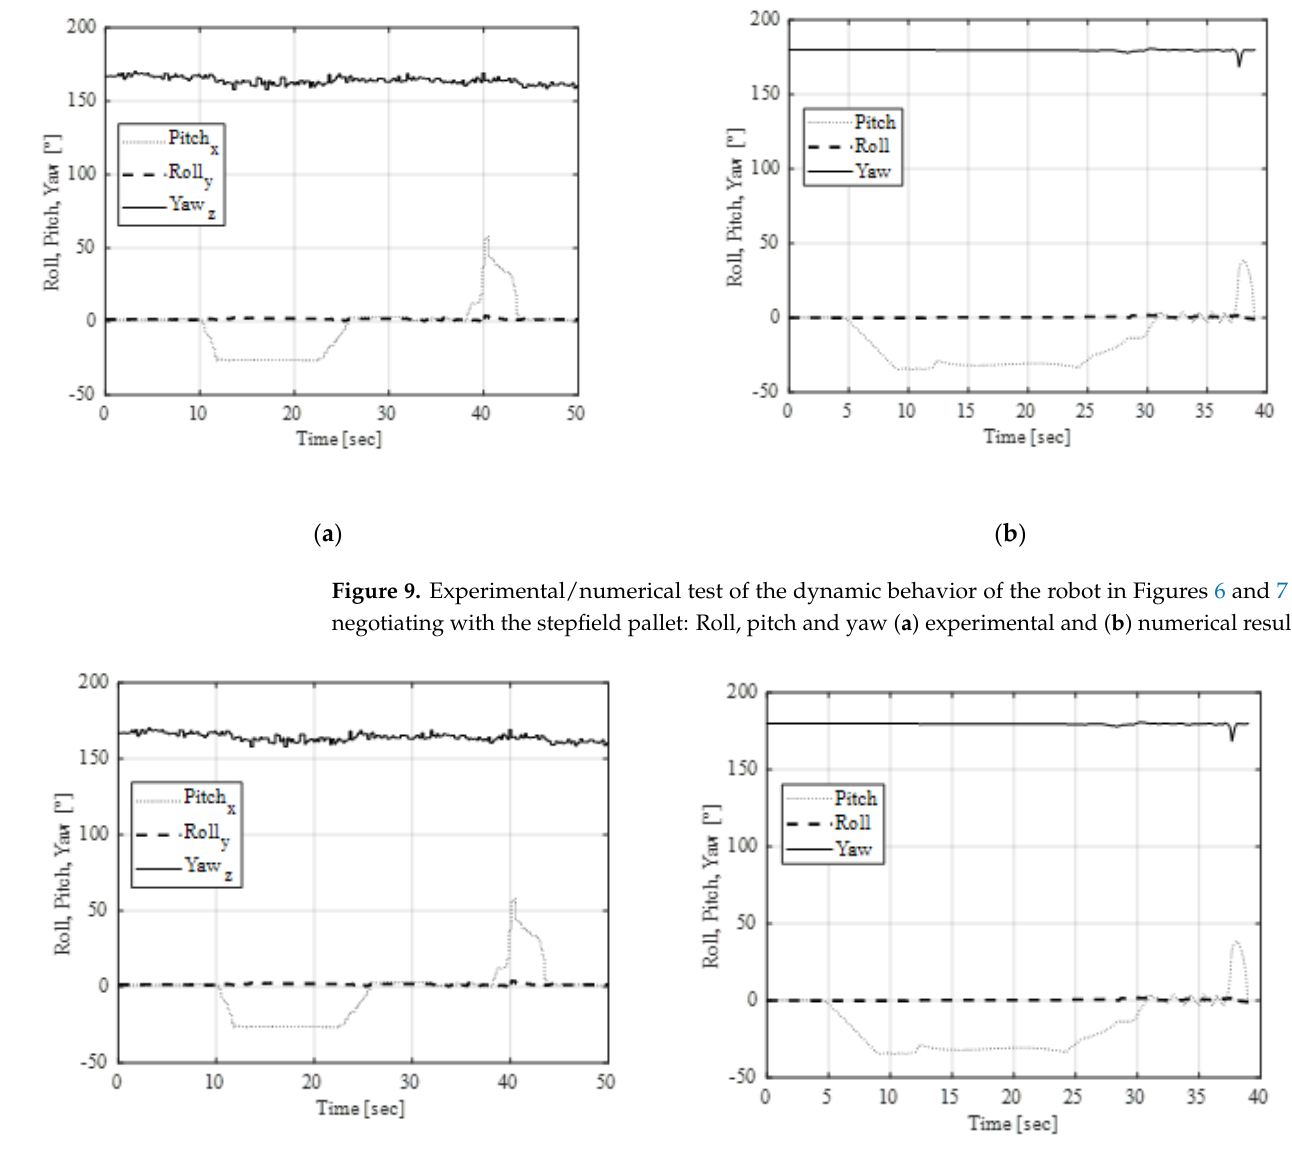
Figure 10. Experimental/numerical test of the dynamic behavior of the robot in Figures 6 and 7 in negotiating with the stepfield pallet: linear acceleration ( a ) experimental and ( b ) numerical results.